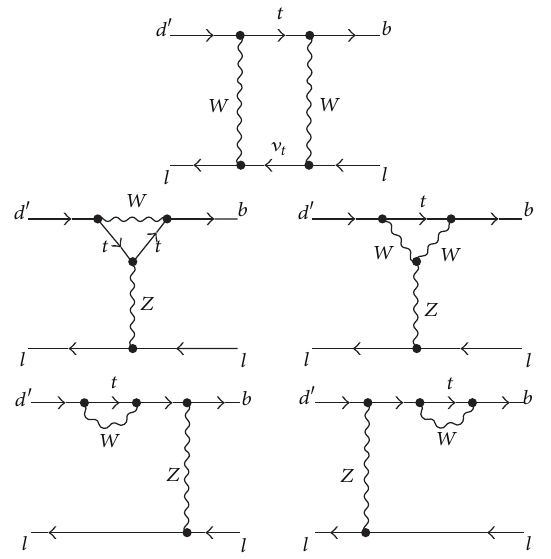
Figure 14: Dominant SM diagrams for the decay 𝐵 𝑑 󸀠 → ℓ + ℓ − , 𝑑 󸀠 = 𝑑 or 𝑠 .